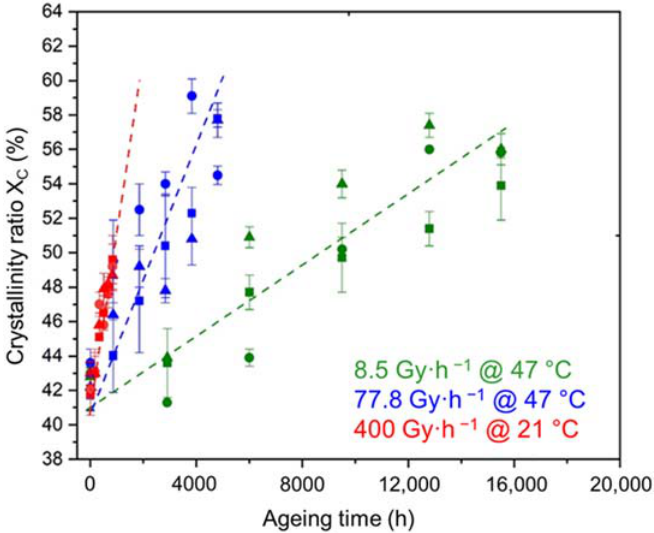
Figure 6. Changes in the mass fraction of crystals in the Si ‐ XLPE matrix filled with 0 phr ( □ ), 25 phr ( ∆ ), and 50 phr ( ) of ATH, during its radio-thermal exposure in air under 8.5 Gy · h − 1 at 47 ◦ C (green), under 77.8 Gy ∙ h − 1 at 47 °C (blue), and under 400 Gy ∙ h − 1 at 21 °C (red).